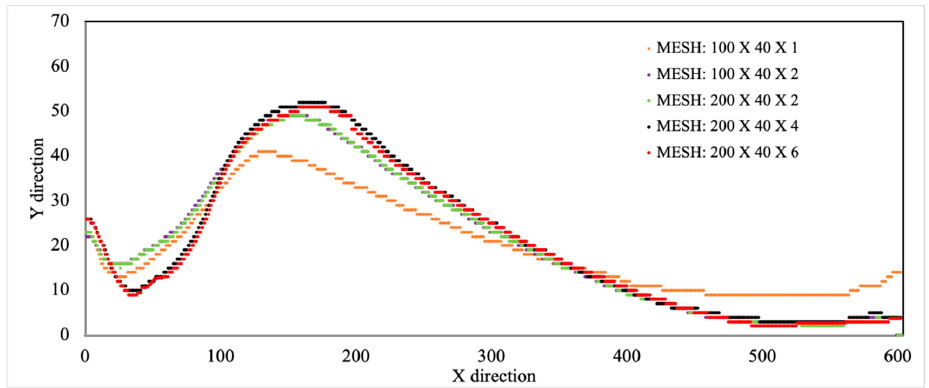
Figure 3. Numerical simulation result of proppant placement profile under different mesh conditions at T = 15 s.